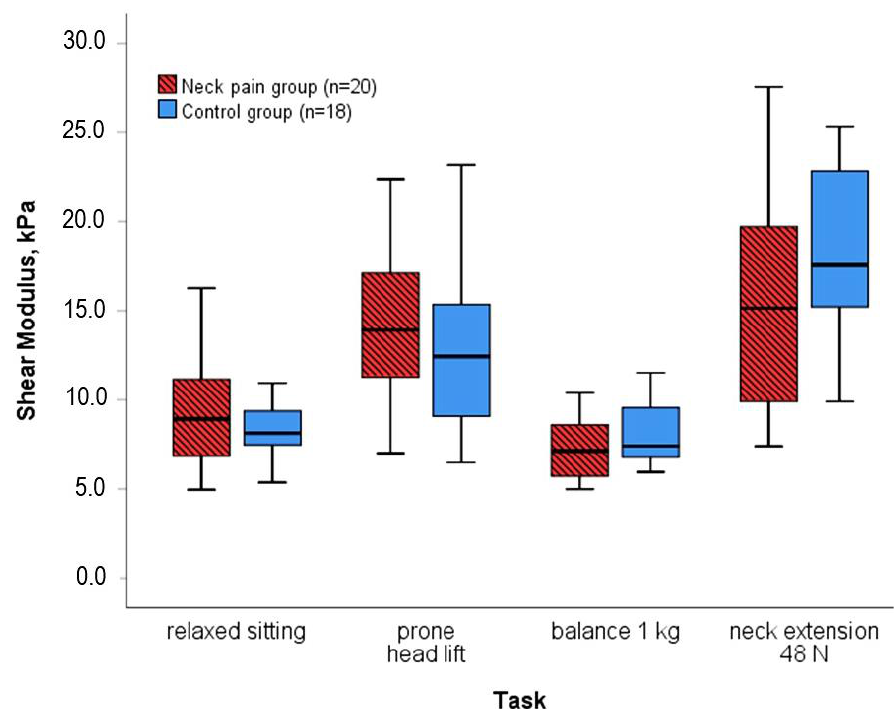
Figure 3. Neck muscle shear modulus of the four tasks that have been used as a reference for nor- malization. Note that median stiffness in the pain group tended to be higher, similar, or lower com- pared to the control group (not significant).